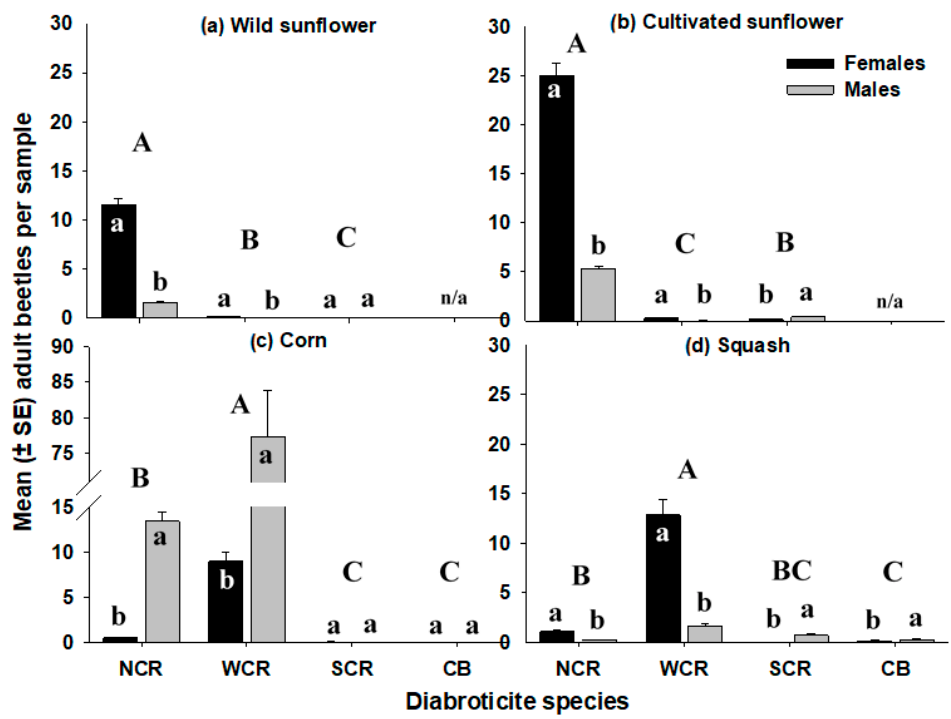
Figure 2. Mean densities ( ± SEM) of adult female and male Diabroticite beetles per sample col- lected in the seasonal survey from: ( a ) wild sunflower, ( b ) cultivated sunflower, ( c ) corn, and ( d ) squash. NCR = northern corn rootworm, D. barberi ; WCR = western corn rootworm, D. v. vir- gifera ; SCR = southern corn rootworm, D. undecimpunctata howardi ; CB = cucumber beetle, A. vittatum . Means with the same letters are not significantly different ( α = 0.05), with upper-case letters indicating differences among species and lower-case letters representing differences between females and